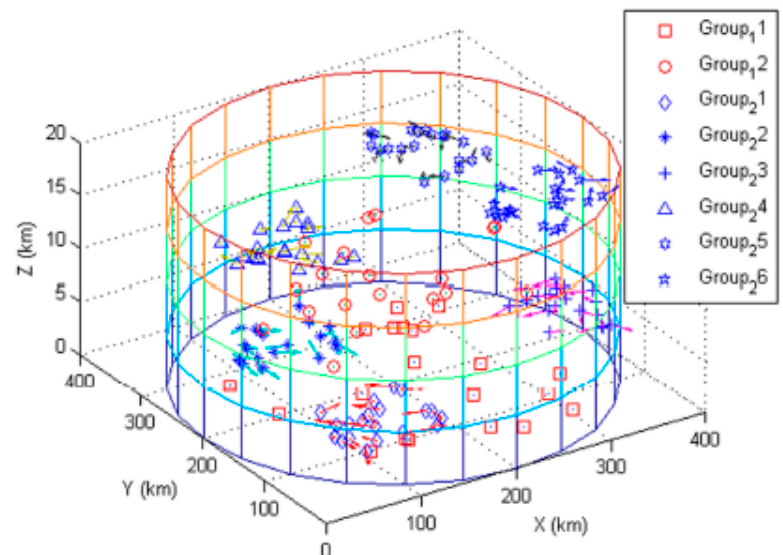
Figure 8. Initial network topologies with 160 nodes.